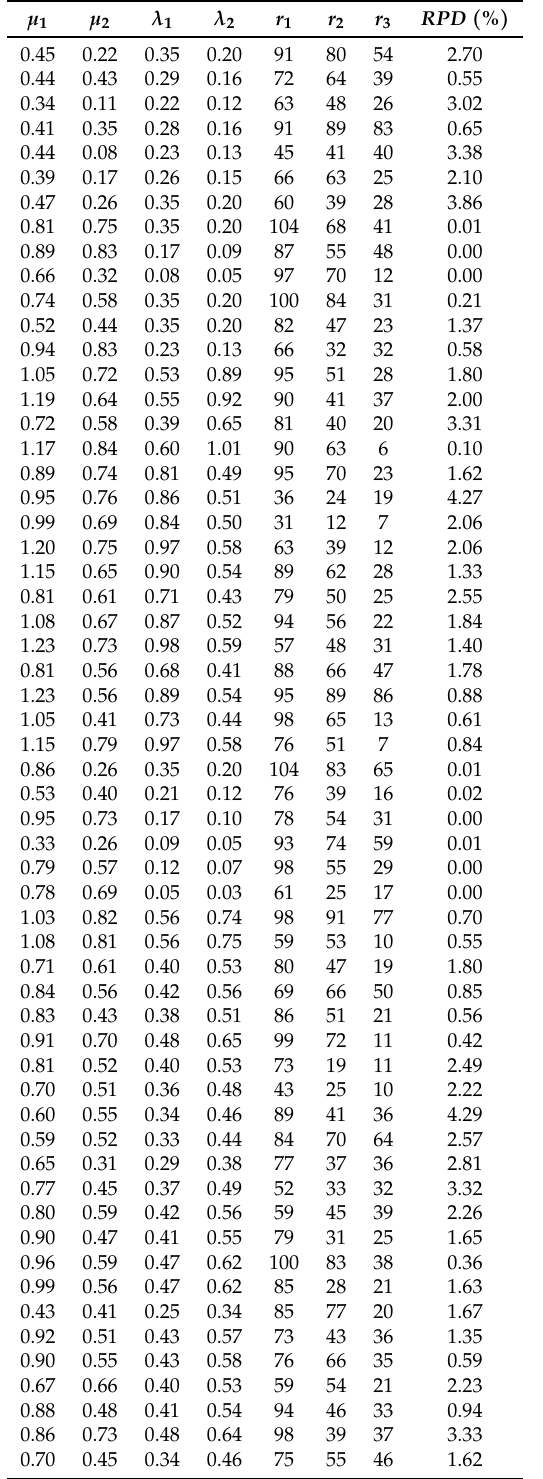
Table 1. Heuristic performance compared to the optimal policy. RD is used as a measure of the Heuristic performance compared to the optimal